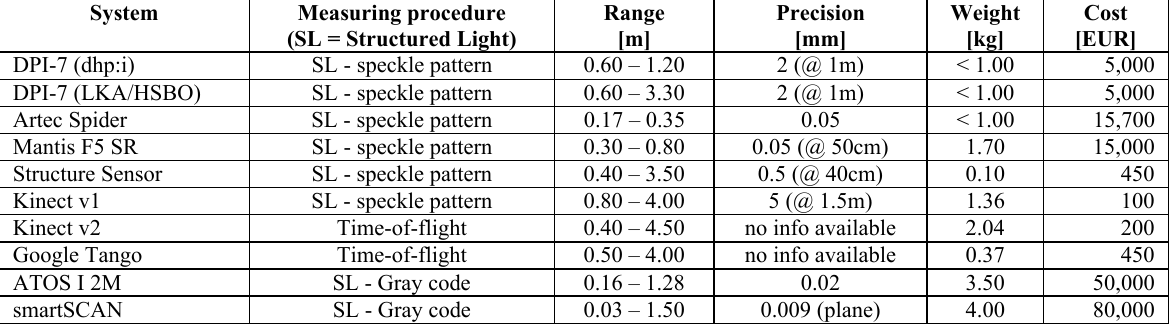
Table 1. Selected technical data of the examined 3D scanners (manufacturer's